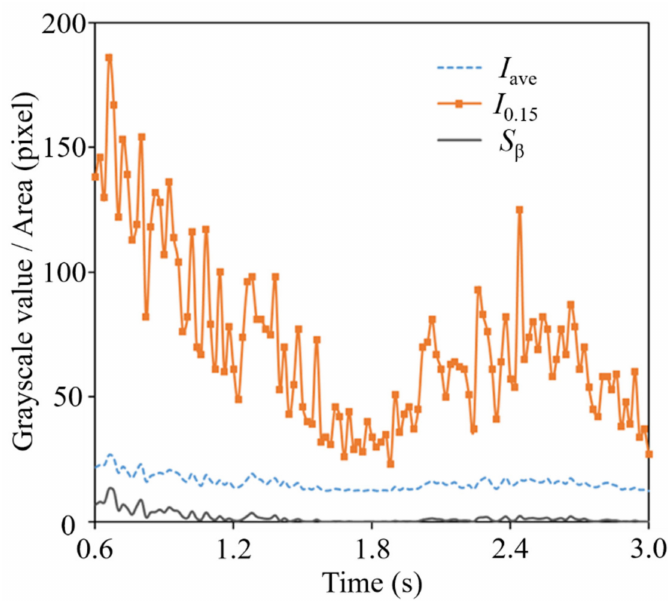
Figure 9. Changes of carbon fiber reinforced polymer in each of the three indicators with time. ((1) Pixel brightness I 0.15 corresponding to the top 0.15% of pixels ordered by brightness; (2) area (number of pixels) S β above the brightness β of the image; (3) average brightness I ave of the